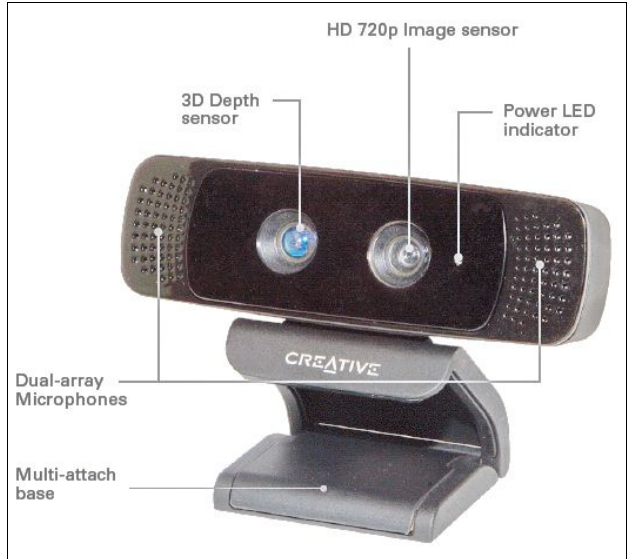
Figure 3. The Creative Senz3D